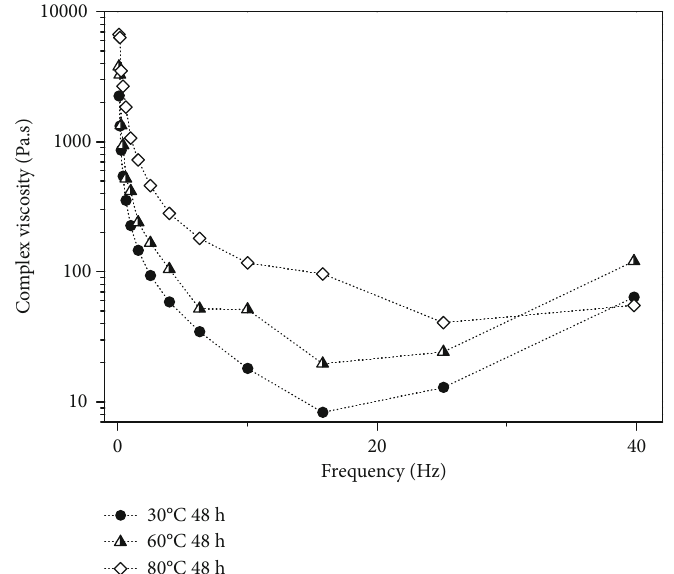
Figure 13: Dependency of complex viscosity on frequency for the H5 samples cross-linked at 30 ° C, 60 ° C, and 80 ° C after 48 hours of swelling.